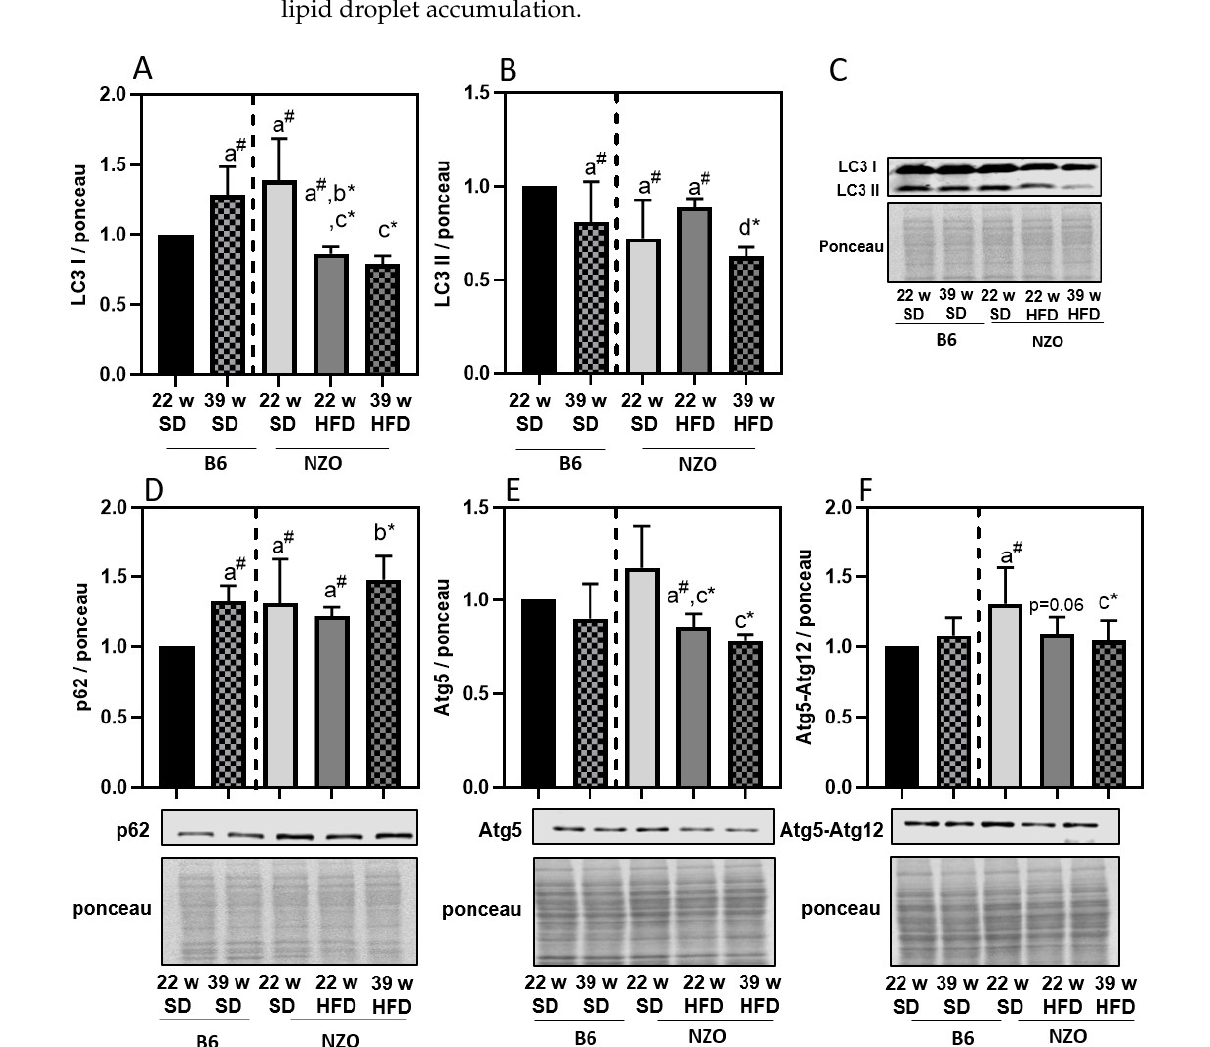
Figure 2. Autophagy-related protein expression in liver of high-fat diet exposed mice. B6 and NZO mice were fed by a standard diet (SD) or a high-fat diet (HFD) as described above. Panel A and panel B shows LC3-I and LC3-II protein amount, whereas p62 (panel D ), Atg5 (panel E ) and Atg5-Atg12 (panel F ) are presented together with respective immunoblots and ponceau staining. Panel C is showing a representative LC3 staining with the relative ponceau staining. All data were normalized towards 22w SD B6 (set as ‘1’). Statistical analysis was performed by one sample t -test (indicated by #) or unpaired t -test (indicated by *), directly comparing two selected samples. Statistical significance means: a—versus 22w B6; b—vs. 39w B6; c—vs. 22w Nzo SD; and d—vs. 22w NZO HFD. The data presented are the mean ± standard deviation, n =